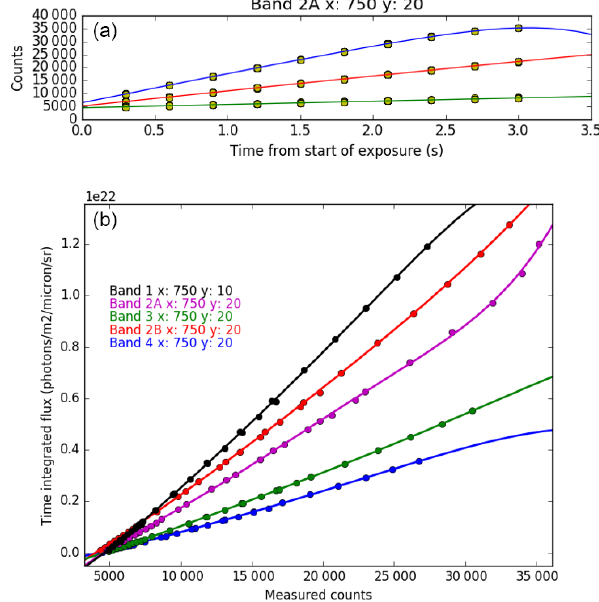
Figure 15. (a) Measurements of the integrating sphere at three different luminances (blue: high luminance, red: mid luminance, green: low luminance – luminance values are listed in Table 4) from a single Band 2A pixel (pixel number 750 along the x axis, 20 along the y axis within the band). (b) Radiometric calibration curve fitted to the integrating sphere observations for a single pixel (pixel num- bers listed in the legend) in each of the five GHOST